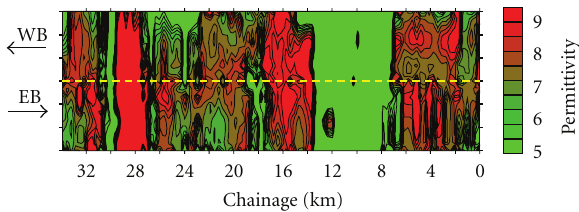
Figure 2: Granular base permittivity contour.